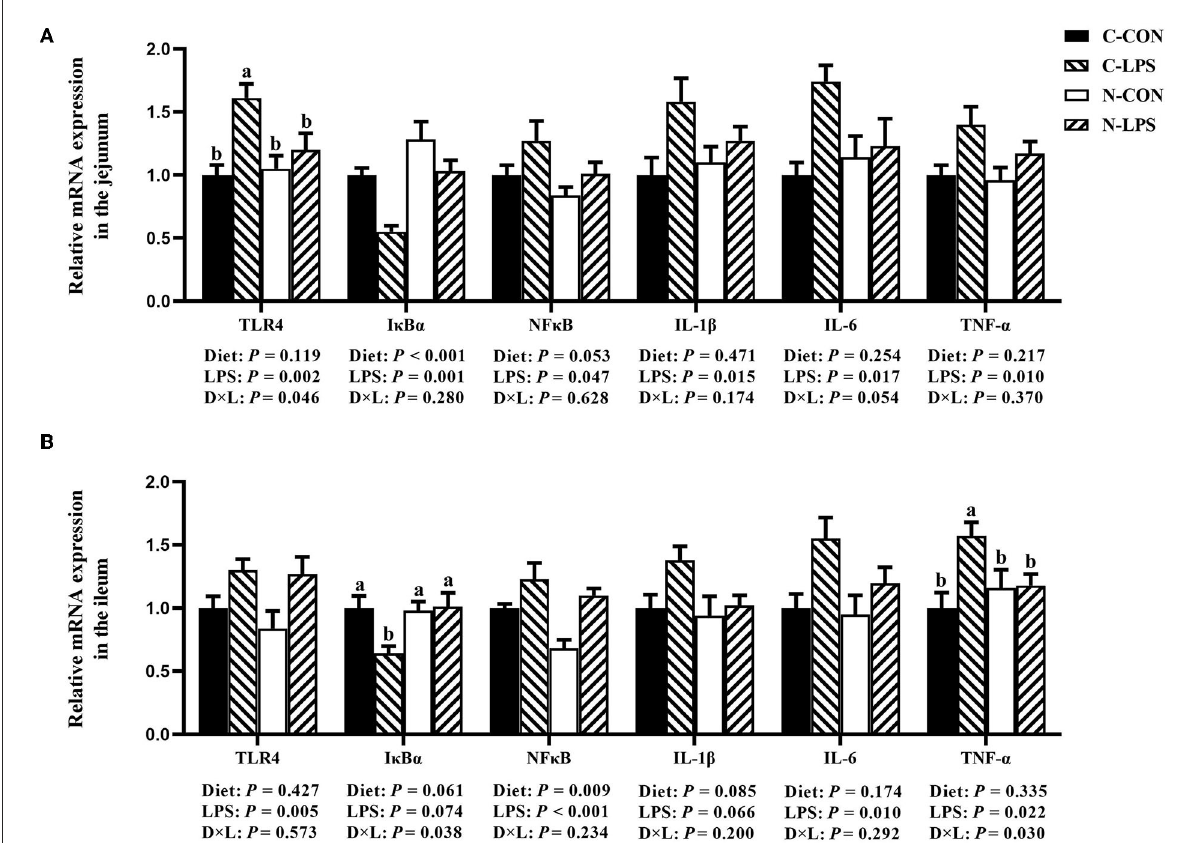
FIGURE3 Effects of maternal nucleotide supplementation on inflammation-related gene expression in jejunum and ileum in lipopolysaccharide- challenged newborn piglets. (A) Relative mRNA expression in jejunum. (B) Relative mRNA expression in ileum. Results were expressed as means with their standard errors, n = 6; a,b Means of the same parameter with different superscripts are significantly different ( P < 0.05). TLR4, toll-like receptor 4; NF κ B, nuclear factor kappa B; I κ B α , nuclear factor kappa B inhibitor alpha; IL-1 β , interleukin-1 β ; IL-6, interleukin-6; TNF- α , tumor necrosis factor- α . C-CON, piglets were from the sows fed with basal diets and were challenged by sterile saline; C-LPS, piglets were from the sows fed with basal diets and were challenged by LPS; N-CON, piglets were from the sows fed with basal diets containing nucleotides and were challenged by sterile saline; N-LPS, piglets were from the sows fed with basal diets containing nucleotides and were challenged by